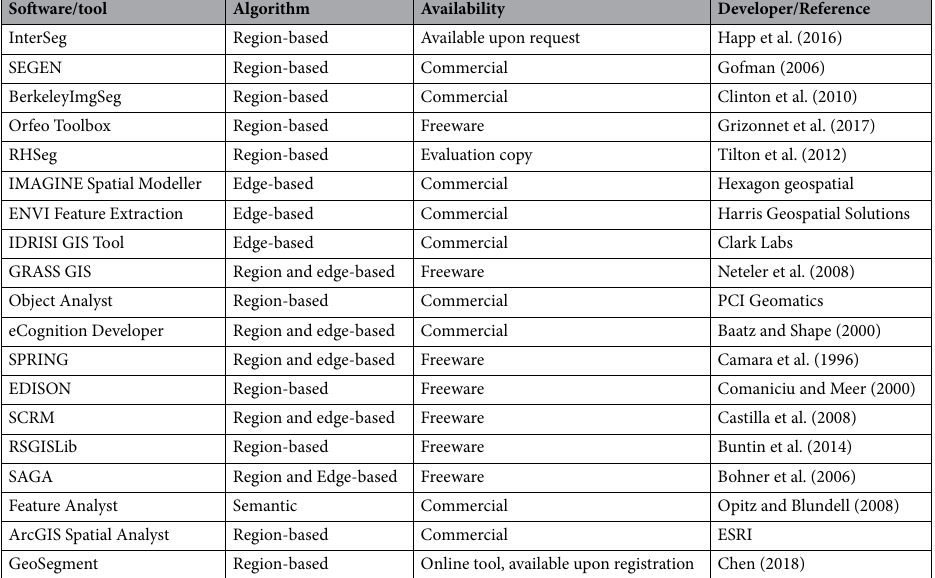
Table 2. All available software/tools, their algorithms, and source for object-based segmentation.